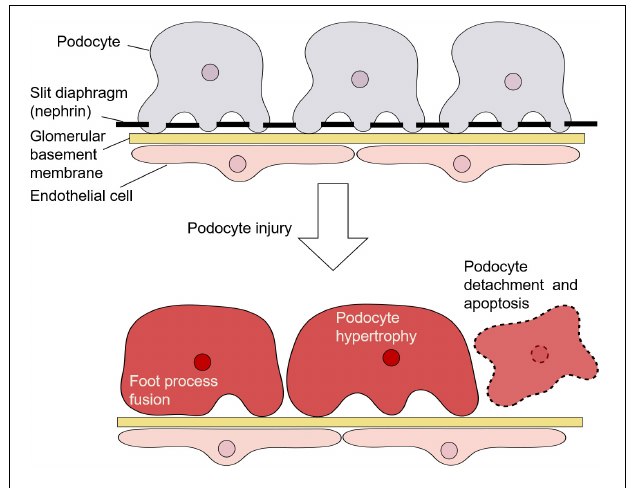
FIGURE 1 | Architecture of podocytes and podocyte